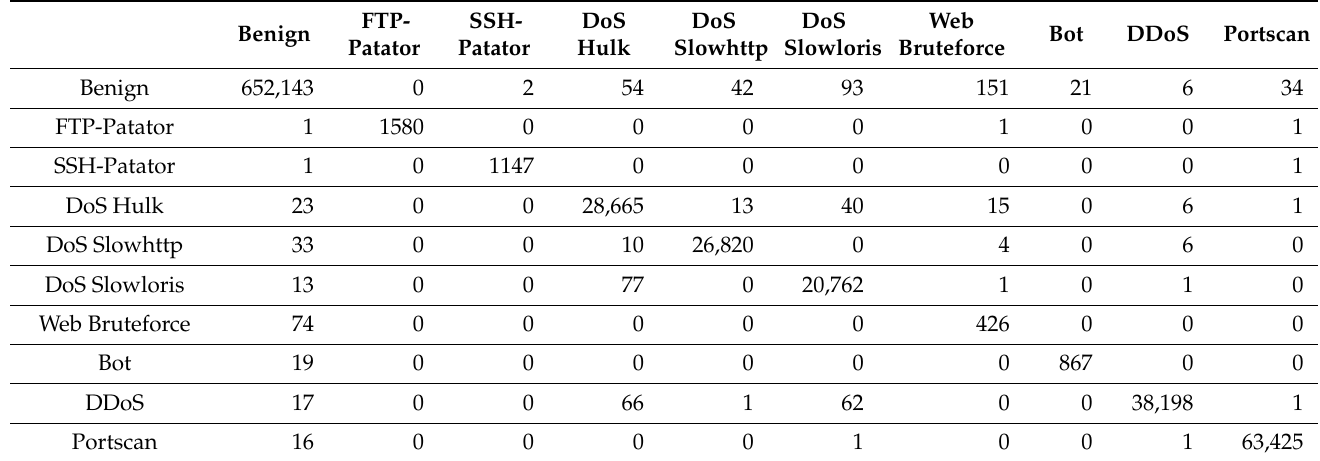
Table 9. Confusion matrix for DTKNN using the multi-host feature.